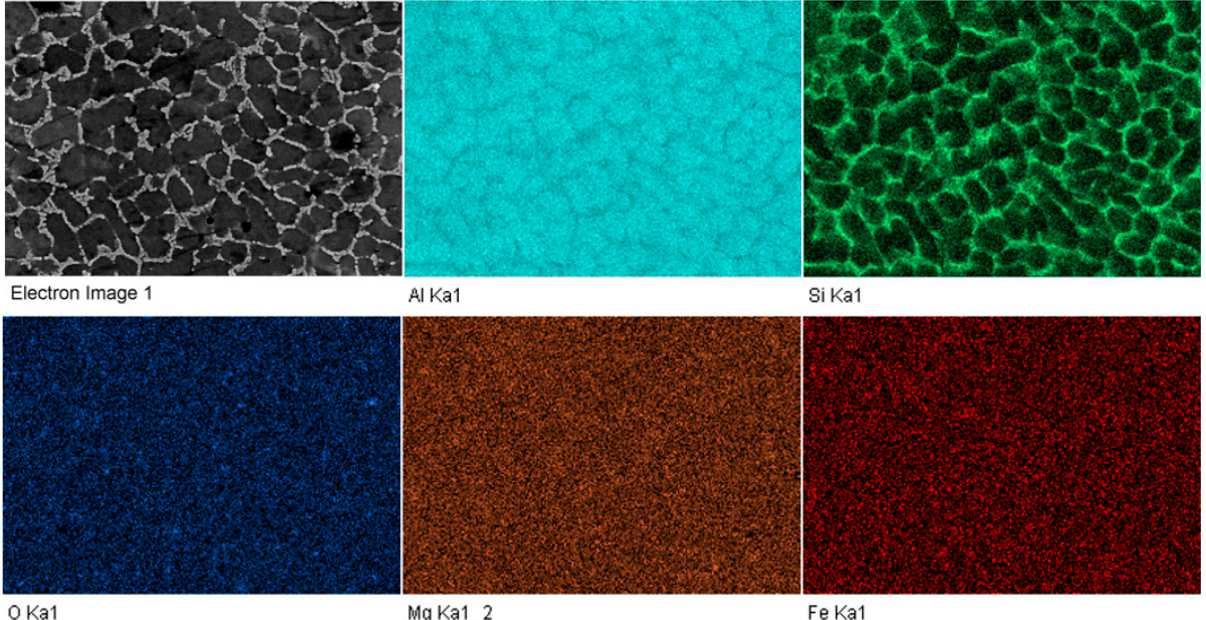
Figure 5. EDS analysis of the chemical composition of as-built L-PBF AlSi10Mg sample in the transverse cross-section.